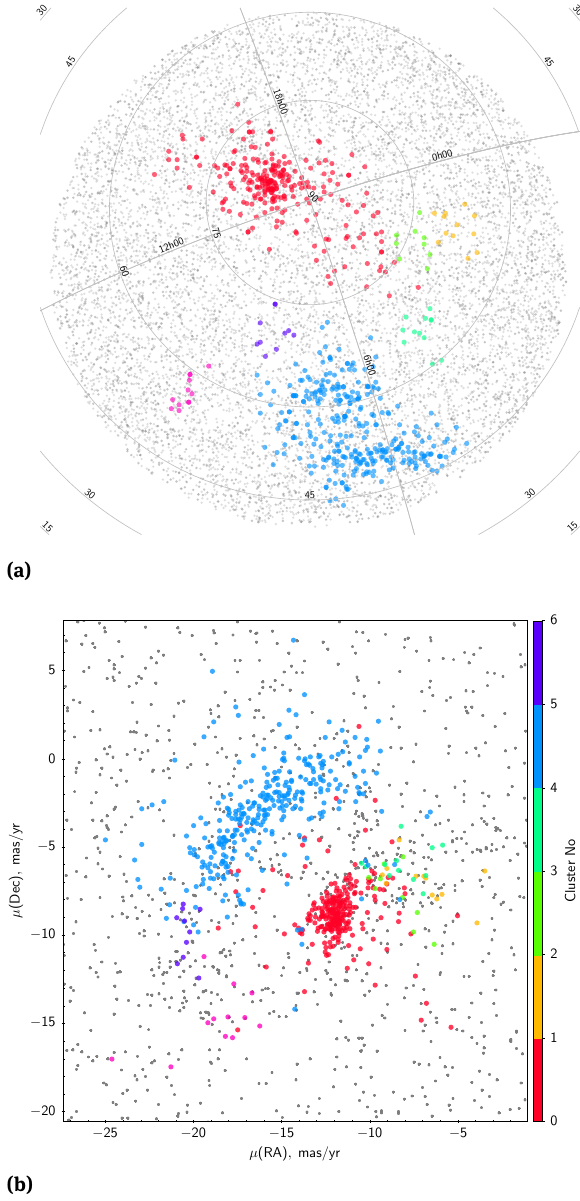
Figure 4. Scatterplots showing the sky positions in (l,b) galactic coordinates (left) and proper motions (right) of stars from clustered real data, coloured in according to which cluster they were allocated to. Grey smaller dots correspond to the stars which were present at least in one pair, but were not attributed to clusters by DBSCAN